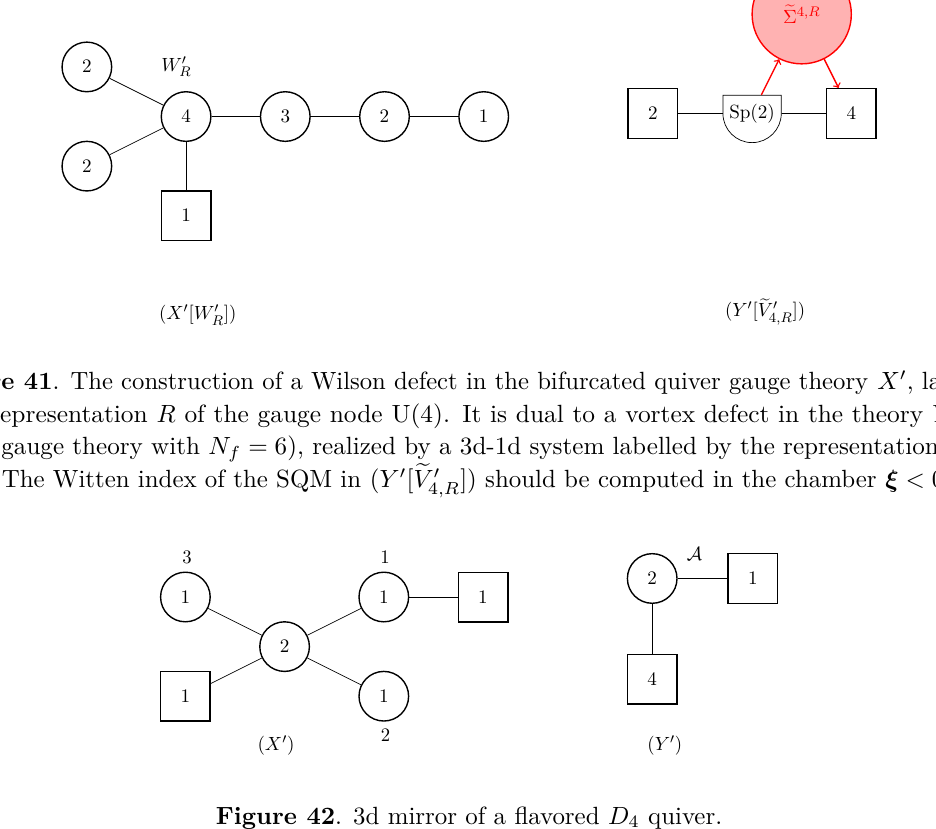
Figure 42 . 3d mirror of a flavored D 4